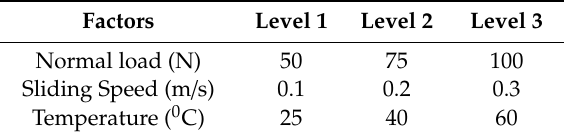
Table 2. Di ff erent factors and the selected levels for each factor. Table 2. Different factors and the selected levels for each factor.